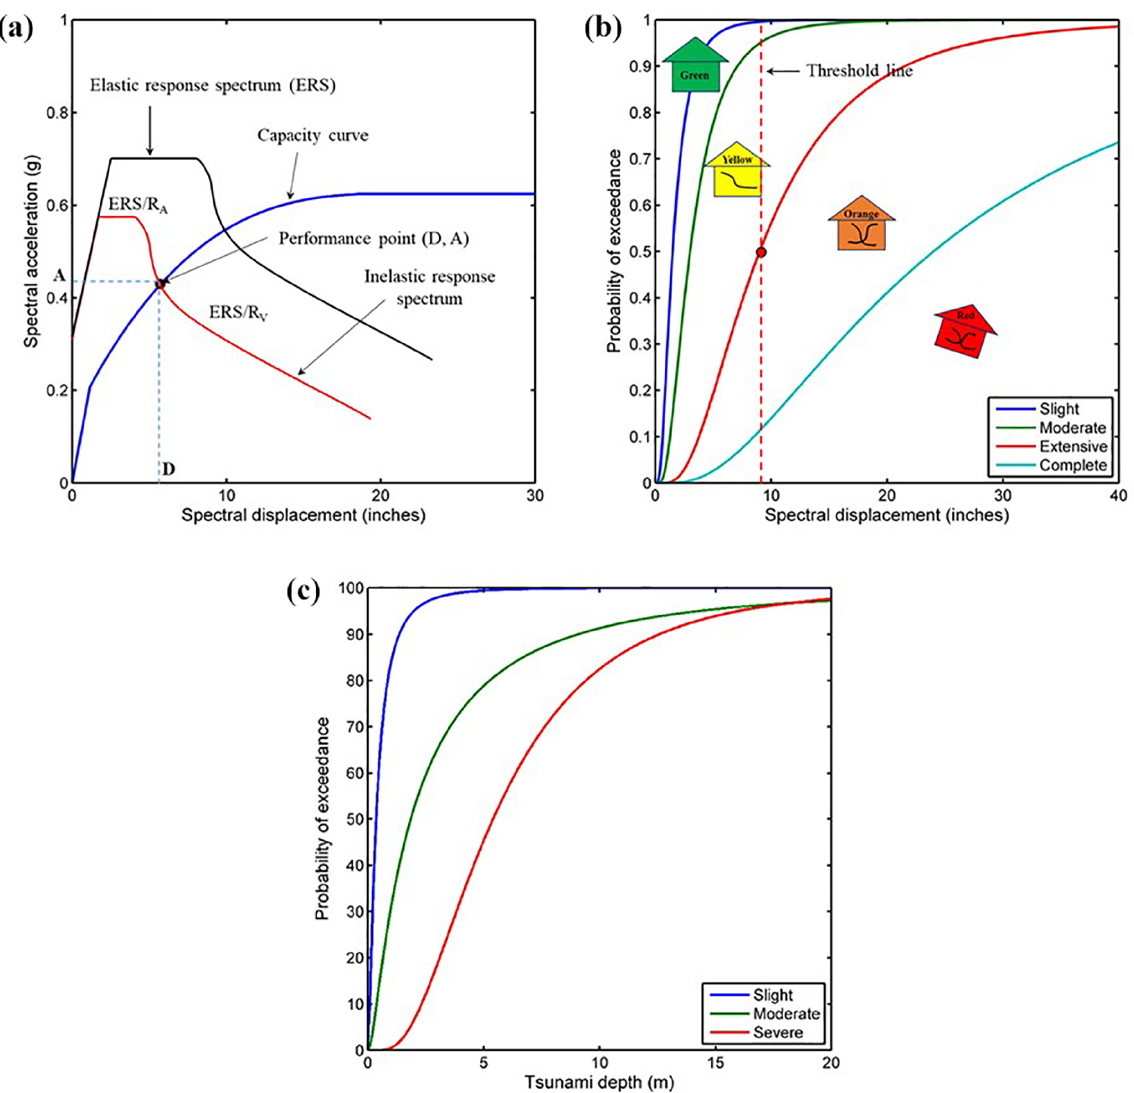
Figure 6. (a) Capacity spectrum method. (b) HAZUS seismic fragility curves. (c) Tsunami fragility curves developed by Suppasri et al.